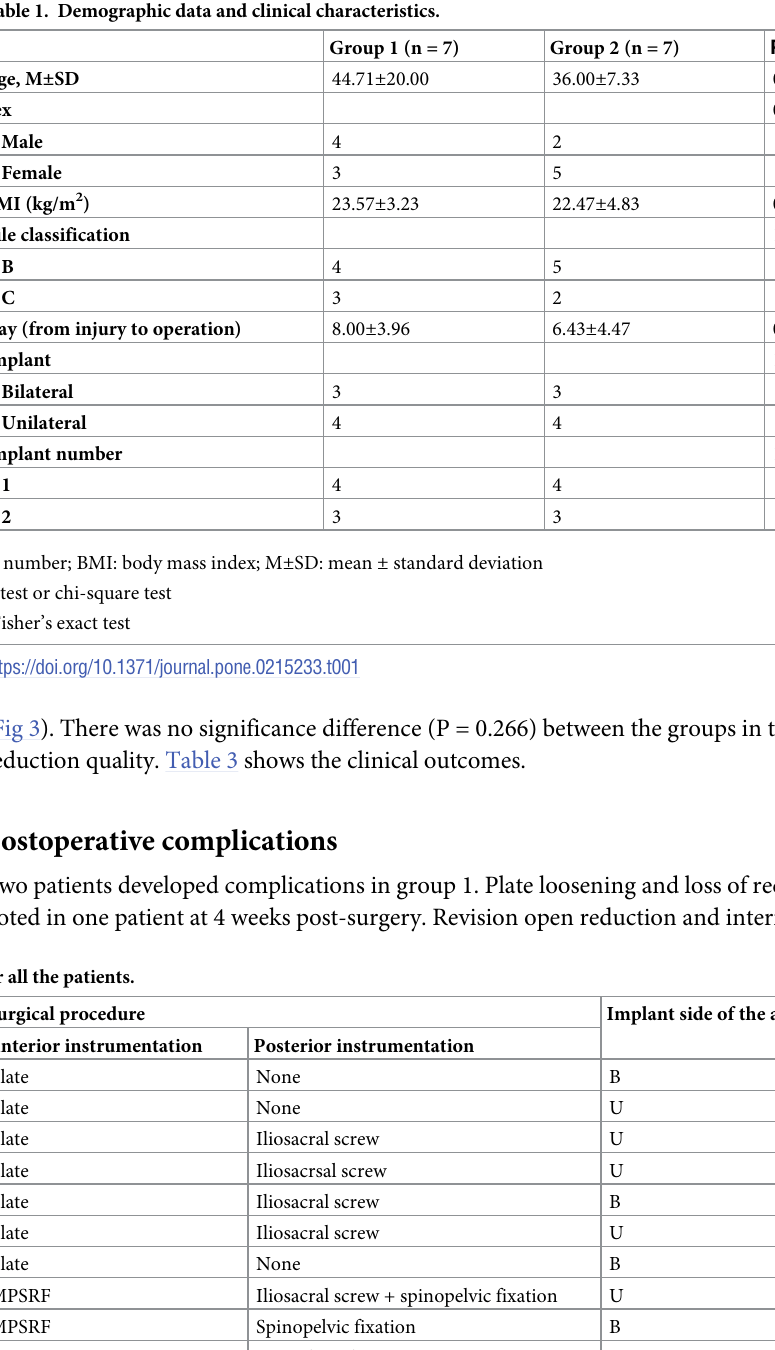
Table 1. Demographic data and clinical characteristics.